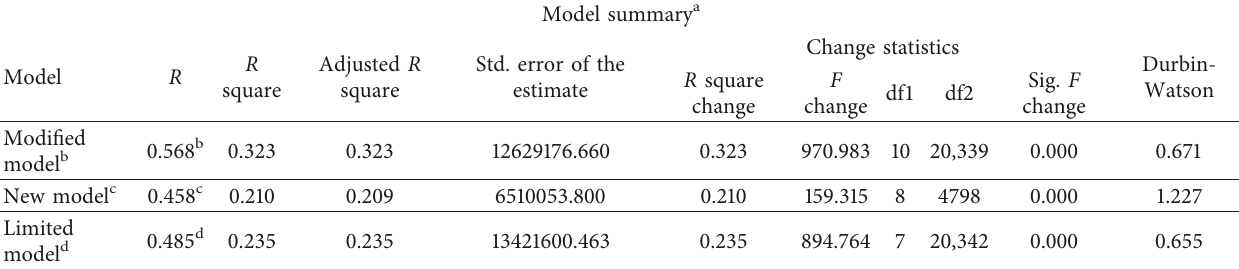
Table 14: Model summary for a DOE medium office building depending on different models.